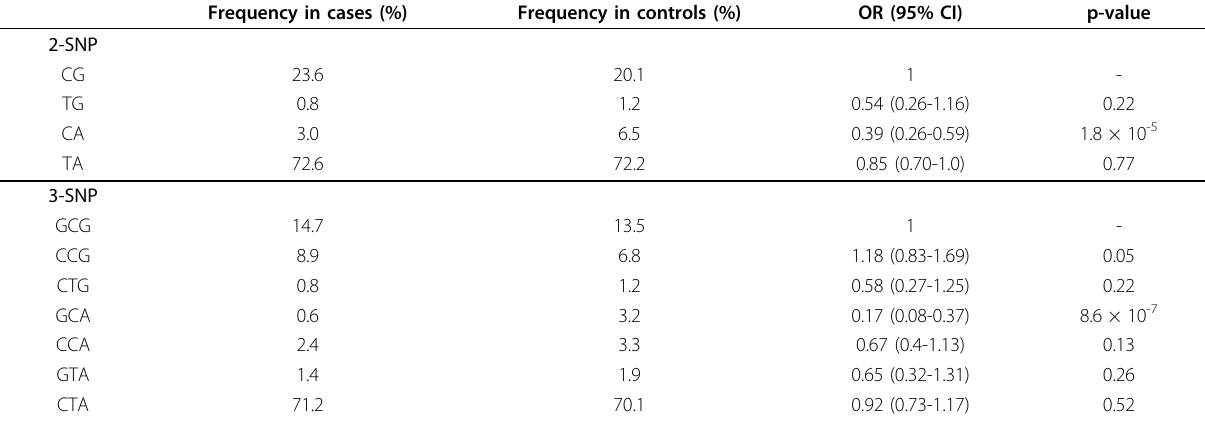
Table 3 Association of ESR1 haplotypes with hip fractures in women. Frequency in cases (%) Frequency in controls (%) OR (95% CI) p-value